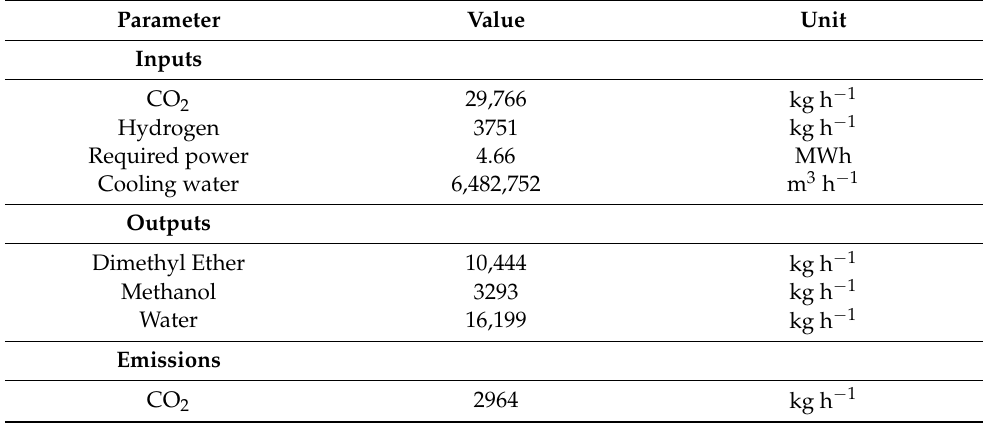
Table 8. Inventory of the dimethyl ether production